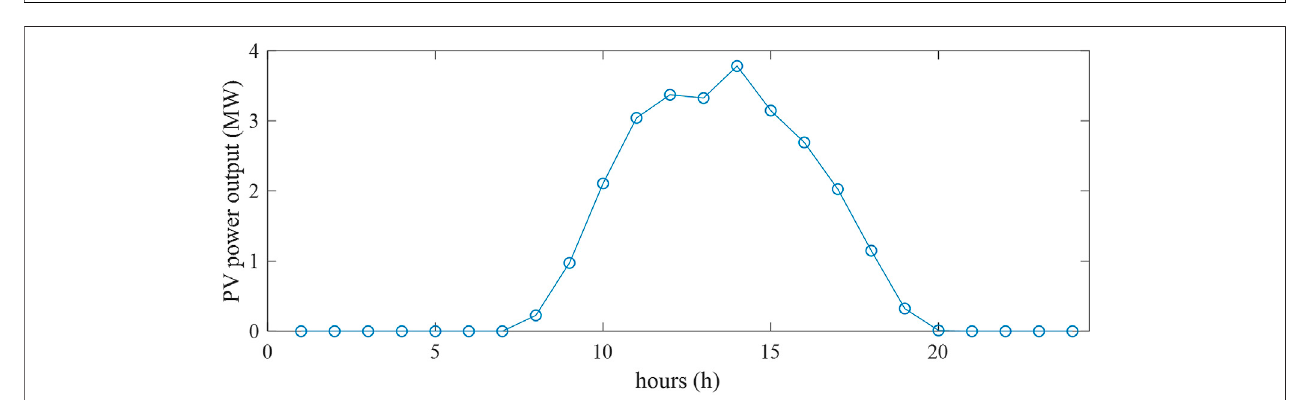
FIGURE 3 | Predicted spot prices.